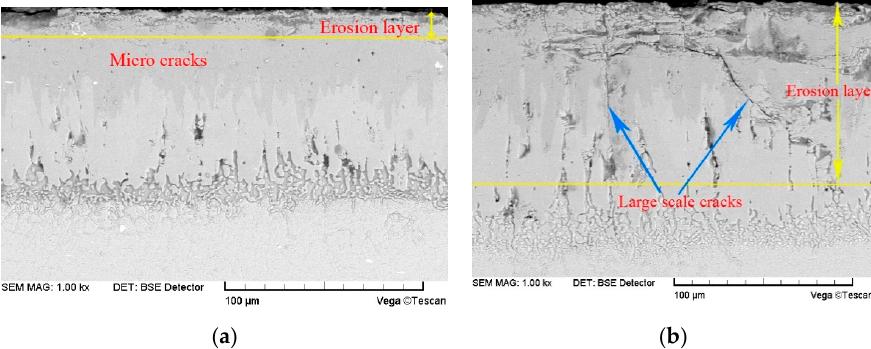
Figure 13. Erosion morphology of the cross-section at 210 m/s, 566 ℃ and 30° condition: ( a ) D 32 = 65 µ m; ( b ) D 32 = 336 µ m.